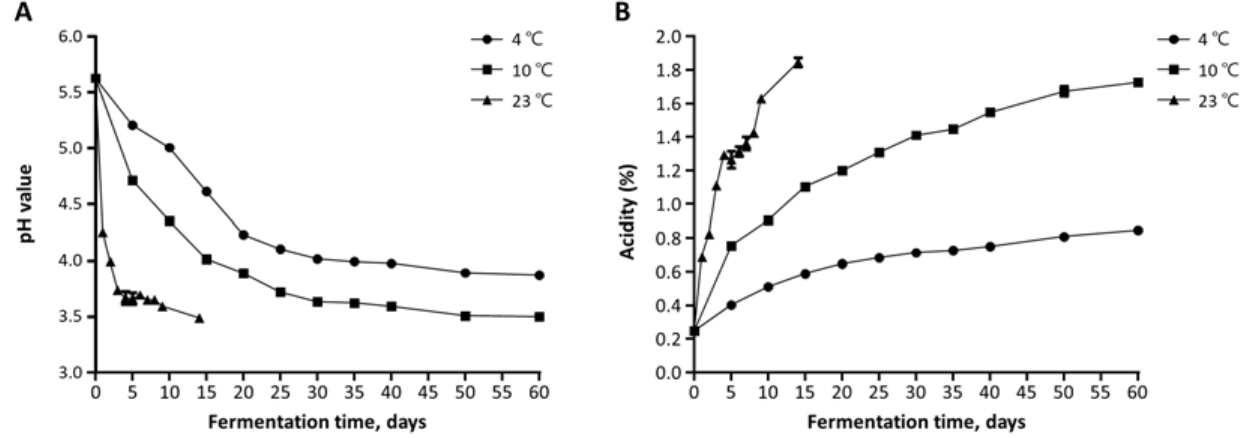
Figure 2. Changes in ( A ) pH and ( B ) acidity of kimchi samples during the fermentation at different fermented temperatures. Error bars represent the standard deviation among the three replicates.